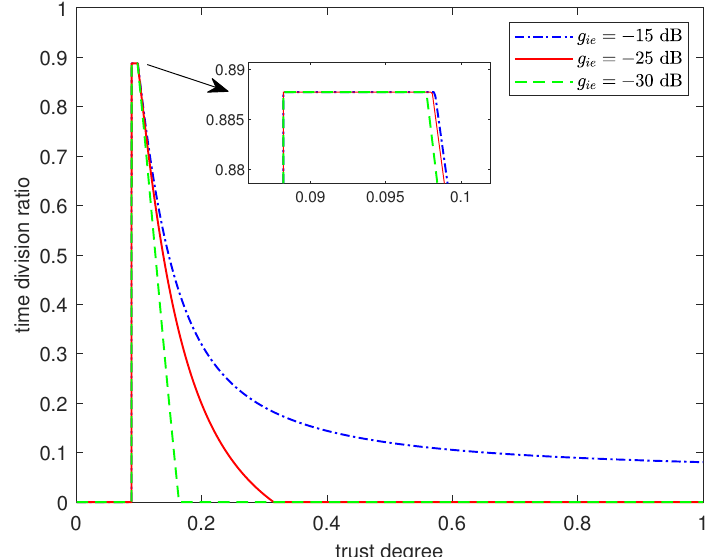
Figure 3. Time division ratio versus trust degree.